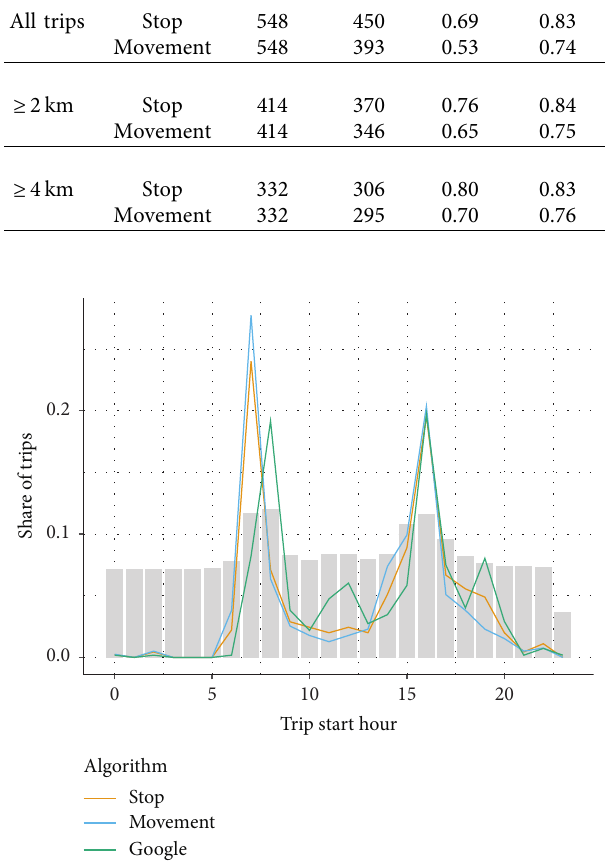
Figure 6: Time distribution of trips by hour detected using the different algorithms and Google location history. The gray bars show the time distribution of the cellular network